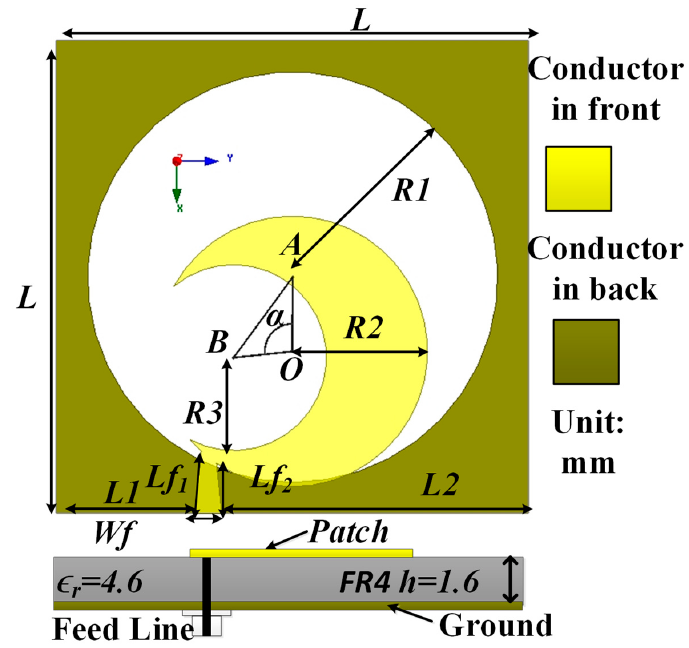
Figure 1. Geometric layout and cross-sectional view of the CP antenna.